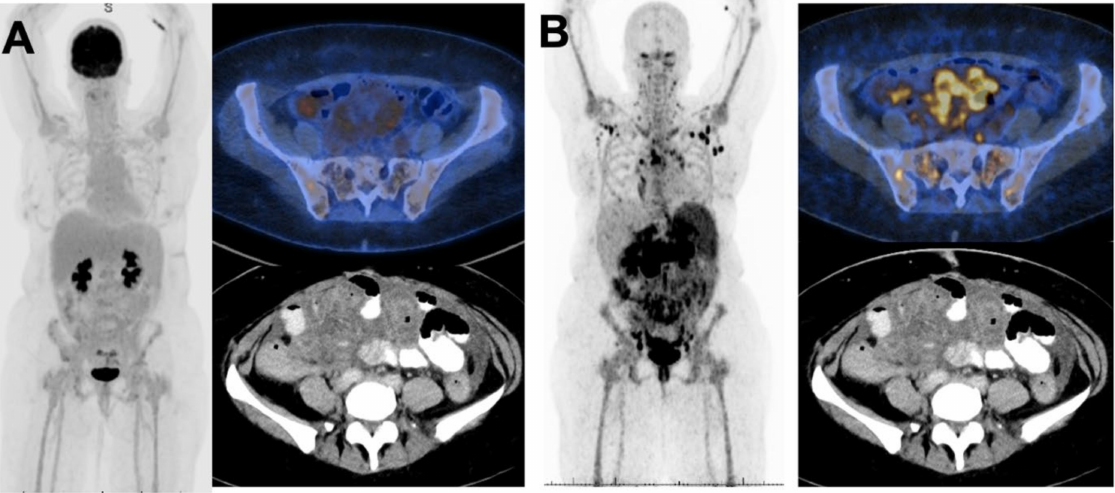
Figure 3. MIP and axial slices from for [ 18 F]FDG PET-CT ( A ) compared to 1 h [ 64 Cu]Cu-SAR-BBN ( B ) in Patient 5 shows bony, nodal and bowel serosal disease was BBN avid but FDG negative.